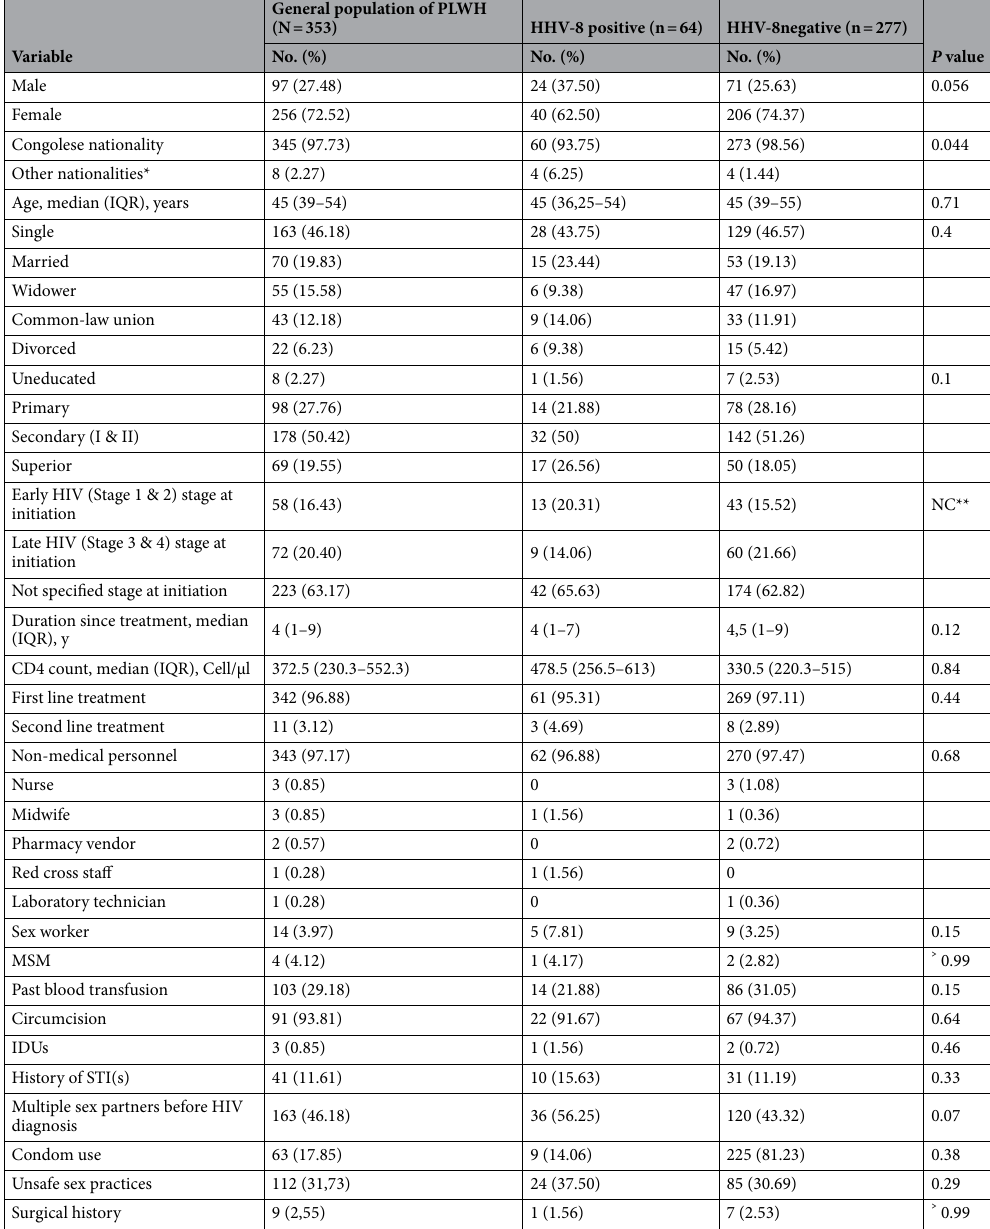
Table 1. Epidemiological characteristics of study population. * Including Central African, Beninese, Cameroonian, DR Congolese, Senegalese. ** no data for everyone. Abbreviation: HIV: human immunodeficiency virus; IDUs: intravenous drug users; IQR: interquartile; MSM: men who have sex with men; NC: non calculated; PLWH: people living with HIV; STI: sexually transmitted